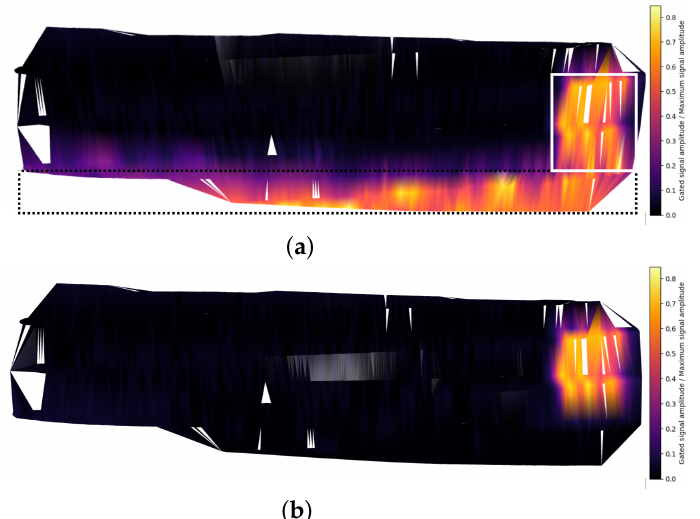
Figure 8. The three ascending side-drilled holes can be seen in the solid box. One disadvantage of this path planning method is the potential for the tool to go over the lip of the part, presenting a second reflection within the gated region as seen in the dashed box. This can be gated out by an operator, as shown. ( a ) Initial image of the part, with static gating applied. ( b ) After dynamic gating, the three side-drilled holes are highlighted, surface reflections caused by non-planar probe apertures have been